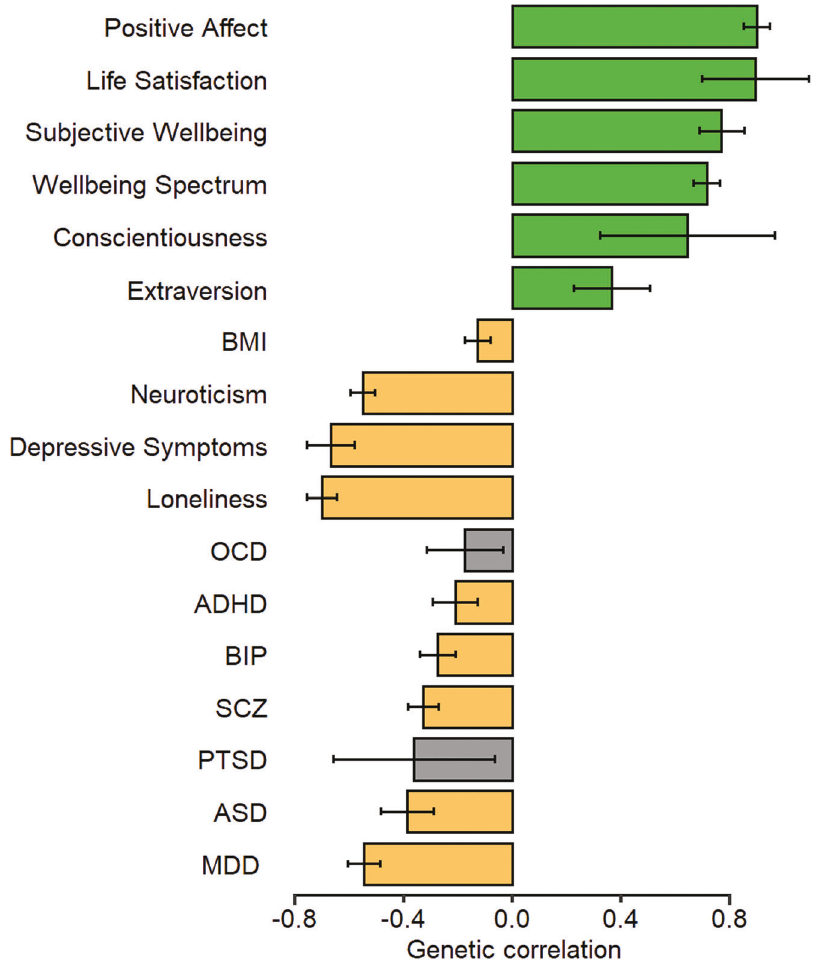
Fig. 3 Genetic correlation ( r g ) between the wellbeing index score and published GWAS of relevant phenotypes and psychiatric disorders. Positively and negatively correlated phenotypes and major psychiatric illnesses were examined using Linkage Disequilibrium Score Regression (LDSC). Published wellbeing-related summary statistics from independent studies included: positive affect, life satisfaction, wellbeing spectrum [10], subjective wellbeing [8], conscientiousness [24], extraversion [25], neuroticism [26], depressive symptoms [8], loneliness [27] and body mass index (BMI) [28]. Published disease-speci fi c summary statistics from independent studies included: major depressive disorder (MDD) [29], bipolar disorder (BIP) [30], schizophrenia (SCZ) [31], attention de fi cit/hyperactivity disorder (ADHD) [32], autism spectrum disorder (ASD) [33], obsessive-compulsive disorder (OCD) [34] and post-traumatic stress disorder (PTSD) [35]. Error bars represent 95% con fi dence intervals (95% CI). Green bars indicate positive r g , orange bars indicate negative r g and grey bars indicate traits with non-signi fi cant genetic correlation after Bonferroni correction ( p > 6.94 × 10 − 4